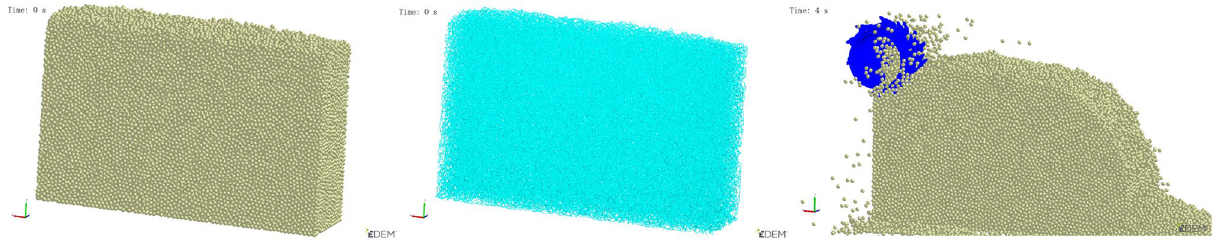
Figure 18. Discrete coal wall cutting